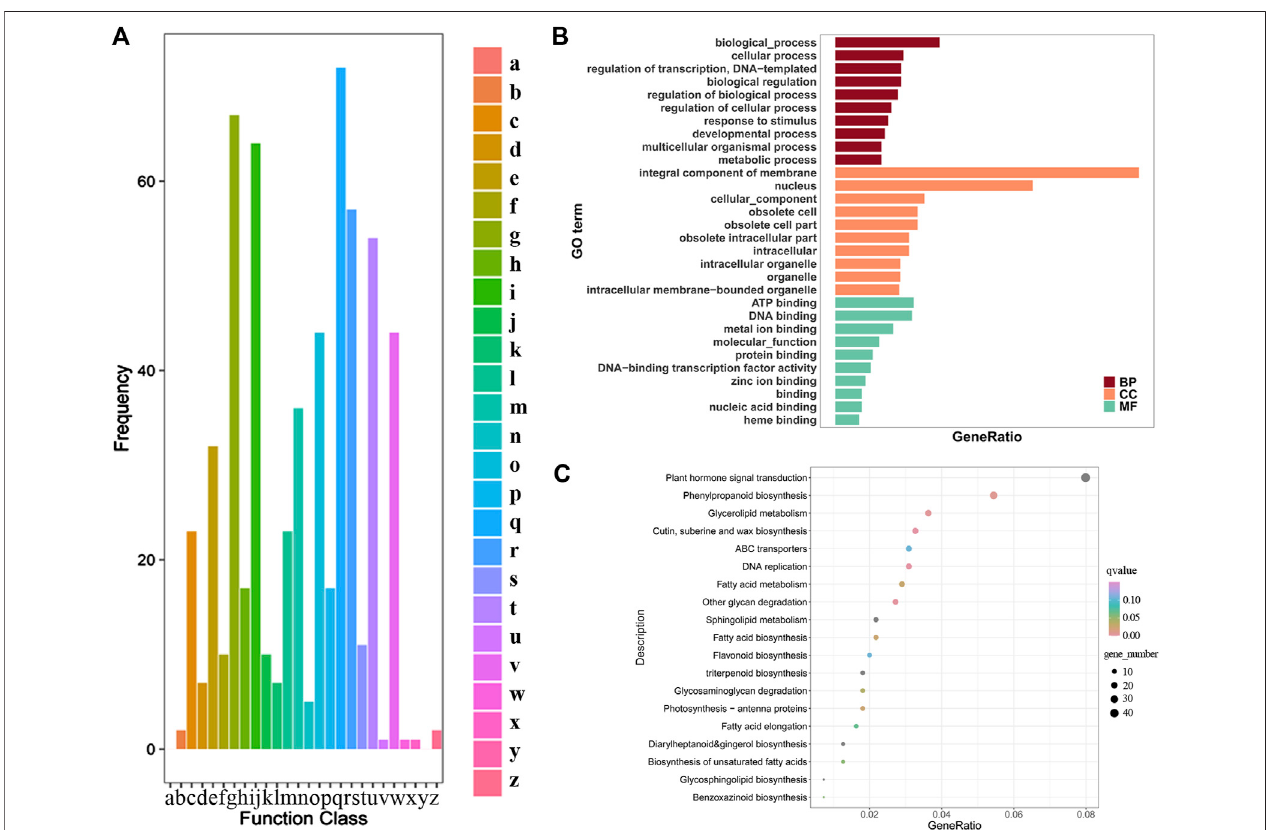
FIGURE 7 | (A) COG Function Classi fi cation of Consensus Sequence. a) RNA processing and modi fi cation; b) Chromatin structure and dynamics; c) Energy productionandconversion;d)Cellcyclecontrol,celldivision,chromosomepartitioning;e)Aminoacidtransportandmetabolism;f)Nucleotidetransportandmetabolism; g) Carbohydrate transport and metabolism; h) Coenzyme transport and metabolism; i) Lipid transport and metabolism; j) Translation, ribosomal structure and biogenesis;k)Transcription;l)Replication, recombination andrepair;m)Cellwall/membrane/envelope biogenesis;n)Cellmotility; o)Posttranslationalmodi fi cation, protein turnover, chaperones p) Inorganic ion transport and metabolism; q) Secondary metabolite biosynthesis, transport and catabolism r) General function prediction only; s) Function unknown; t) Signal transduction mechanisms; u) Intracellular traf fi cking, secretion, and vesicular transport; v) Defense mechanisms; w) Extracellular structures; x) Mobilome: prophages, transposons; y) Nuclear structure; z) Cytoskeleton. Characterization of GO (B) and KEGG (C) enrichment result for transcriptome